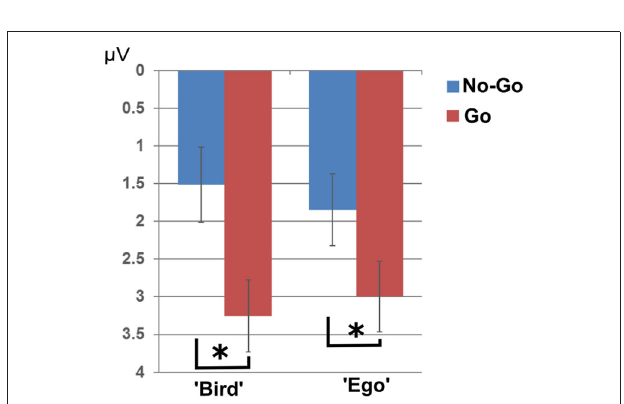
FIGURE 5 | P2 effect. P2 amplitudes showed significantly larger amplitudes for “Go”- compared to “No-go” targets. This effect was stronger in the “Ego” compared to the “Bird” condition. The asterisks indicates significance at a p -value of 0.05.